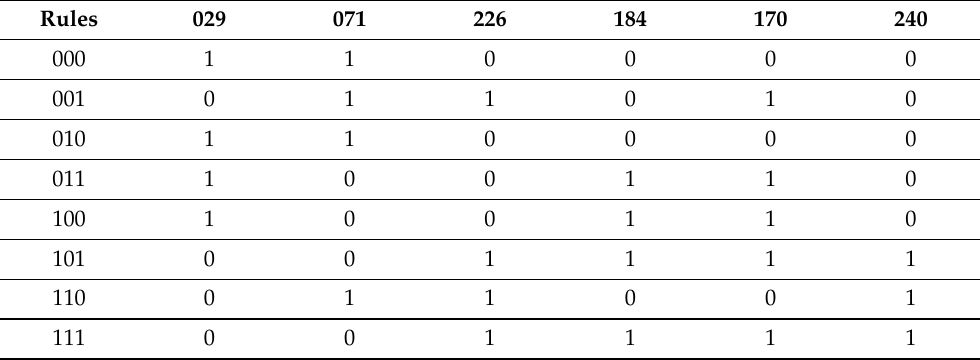
Table 2. Rules of elementary cellular automata interpreted as traffic models (Pt.